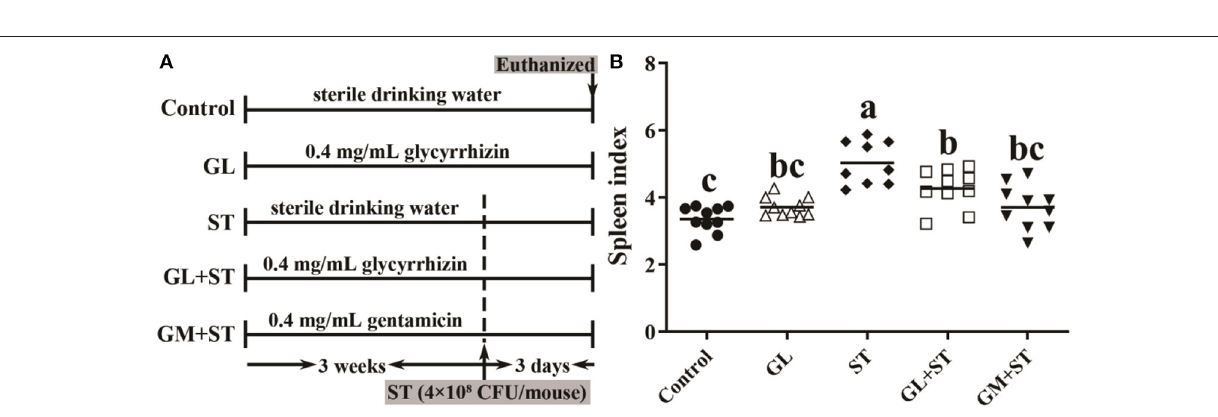
FIGURE 2 | GL alleviates ST-induced splenomegaly. (A) Graphical outline of the animal study. (B) Spleen index. Results are presented as mean ± SD ( n = 10/group). Different lowercase letters indicate a significant difference ( P <